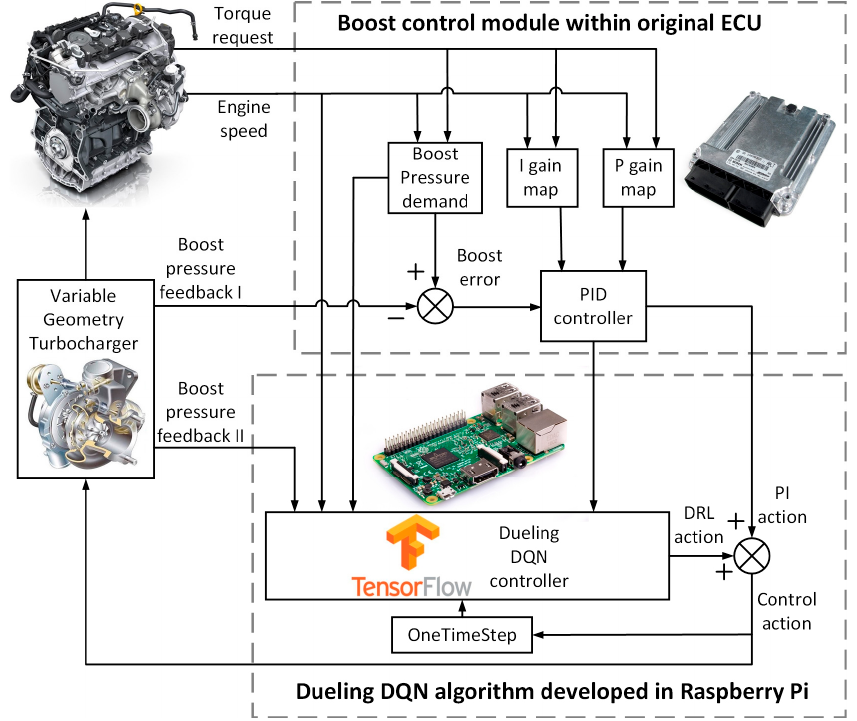
Figure 7. Adaptive hybrid control system schematic combining a dueling deep Q-network and traditional Proportion Integration Differentiation (PID) for a variable geometry turbocharger system.